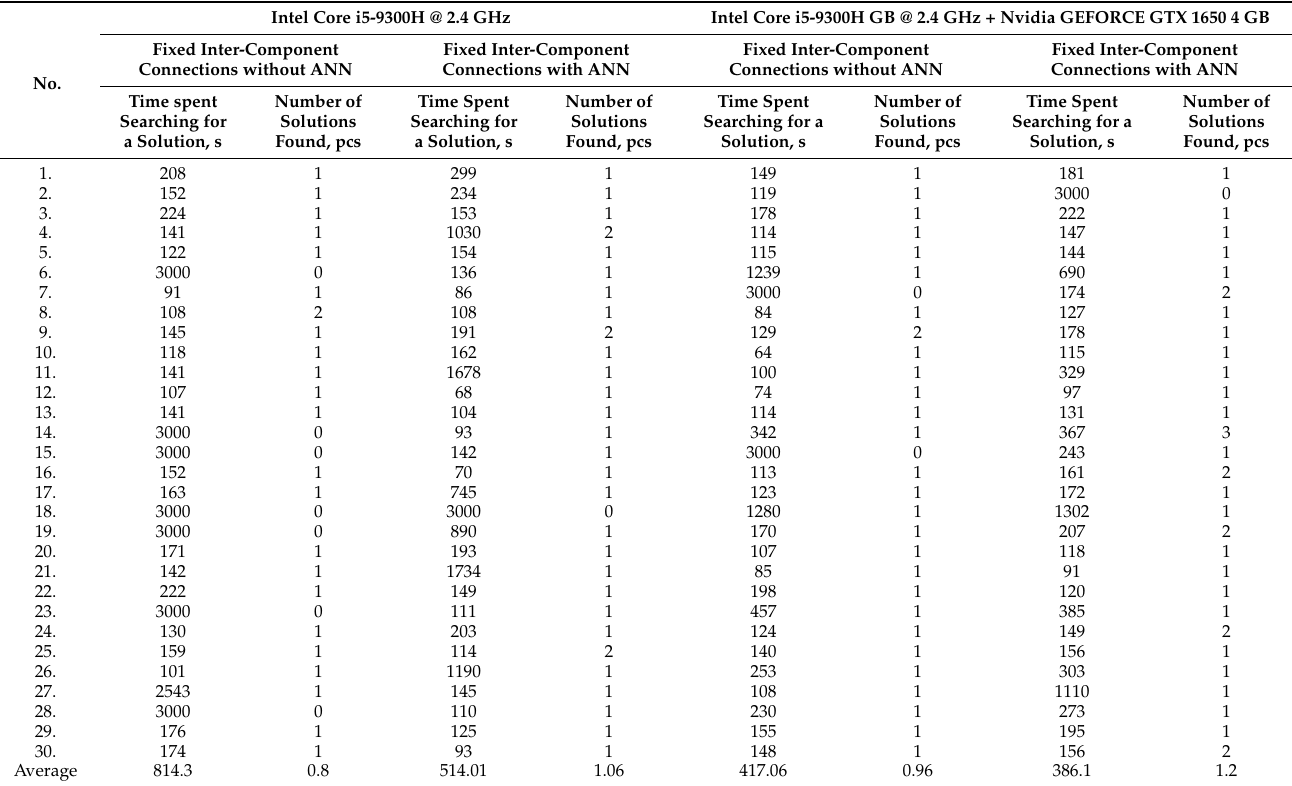
Table 12. Computational experiment